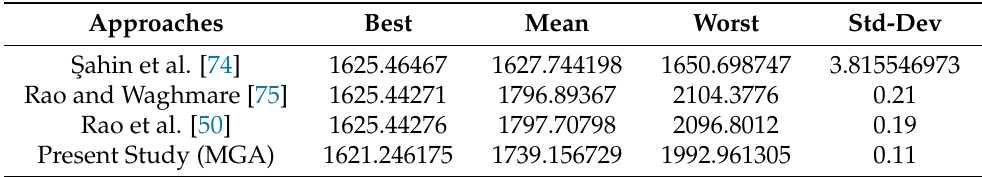
Table 17. Statistical results of different approaches for the hydrostatic thrust bearing design problem. Approaches